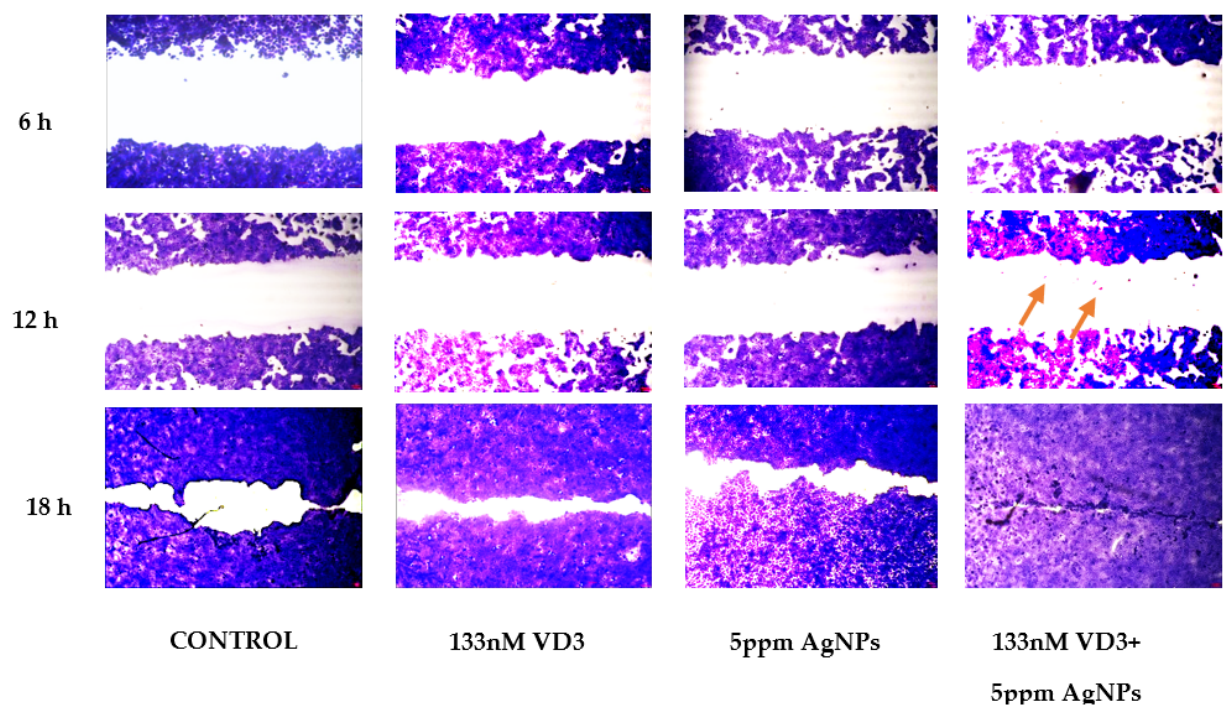
Figure 2. Effect of VD3, AgNPs, and their combination in wound closure. Wound healing assay was performed as reported in Section 4 and microscopy images were analyzed after 6, 12, and 18 h, compared to 0 h.